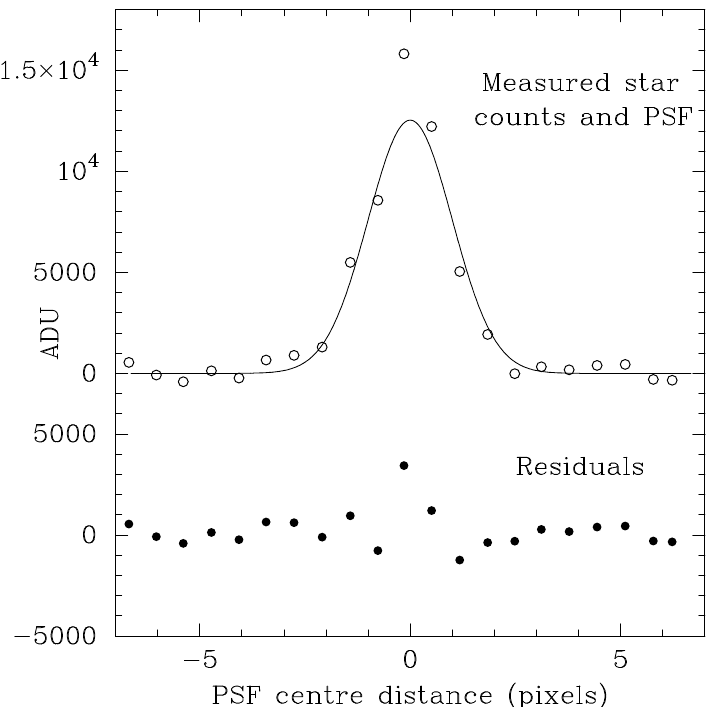
Fig. 1. Upper part: cut through a measured stellar image and a Gaussian PSF fitted to it. Lower part: residuals from the PSF fit; they are largest near the PSF